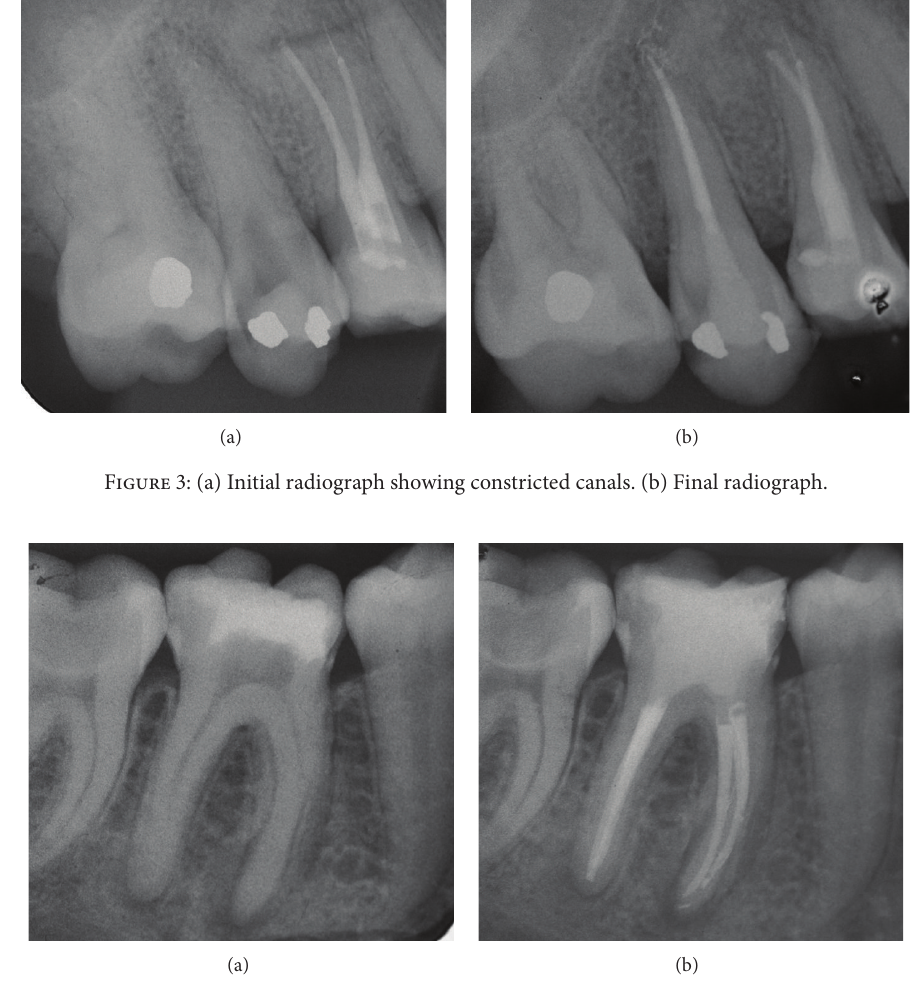
Figure 4: (a) Initial radiograph showing constricted canals mainly in the apical and medium thirds of the mesial root. (b) Final